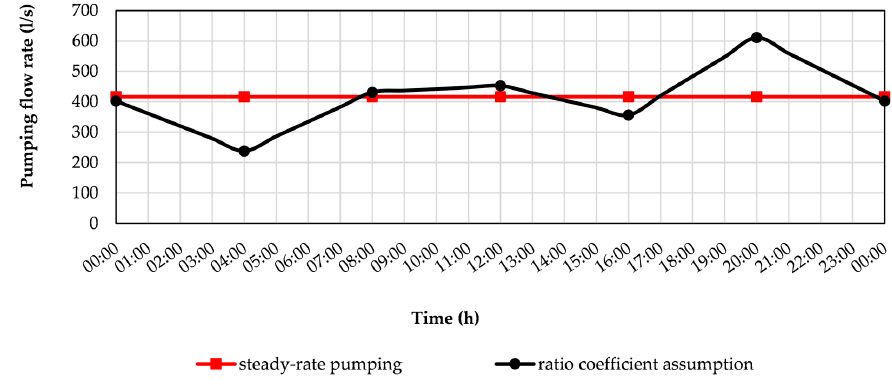
Figure 16. Pumping flow rate values serving as initial population for the six variables of the optimization problem according to two different pumping approaches. The figure concerns a specific loading scenario with moderate H 2 S production results in the network pipes.